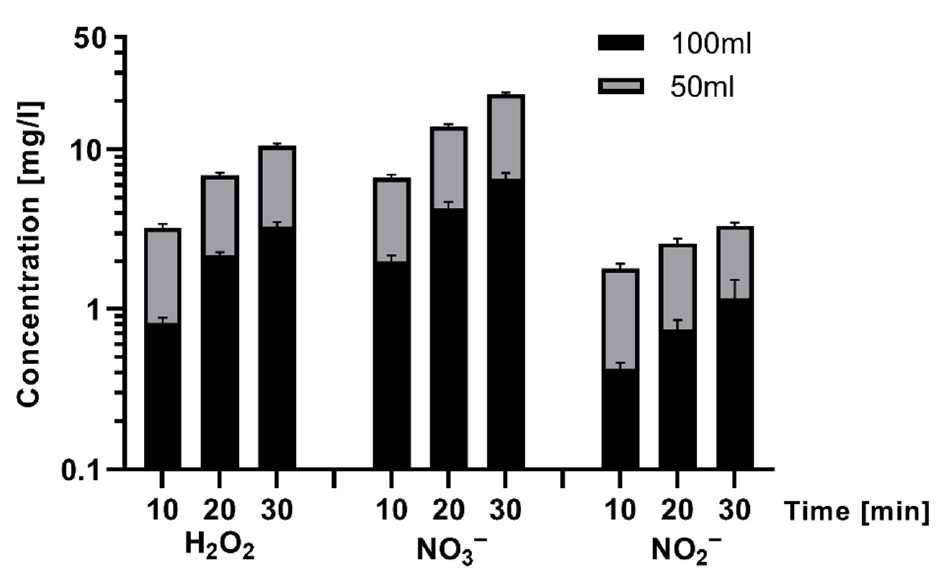
Figure 4. Concentration of the reactive species as a function of treatment time (min) with plasma for two sample volumes (50 and 100 mL). Two-way ANOVA, p < 0.05.